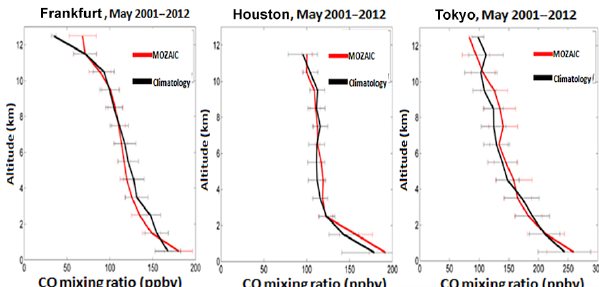
Figure 5. Comparisons of trajectory-mapped MOZAIC-IAGOS CO climatology and MOZAIC-IAGOS profiles at three sites. The cli- matology profiles for each location were produced by excluding data from that location but using all other MOZAIC-IAGOS data. The horizontal error bar half-length is twice the standard error of the mean (equivalent to 95% confidence limits on the averages when the number of data points is